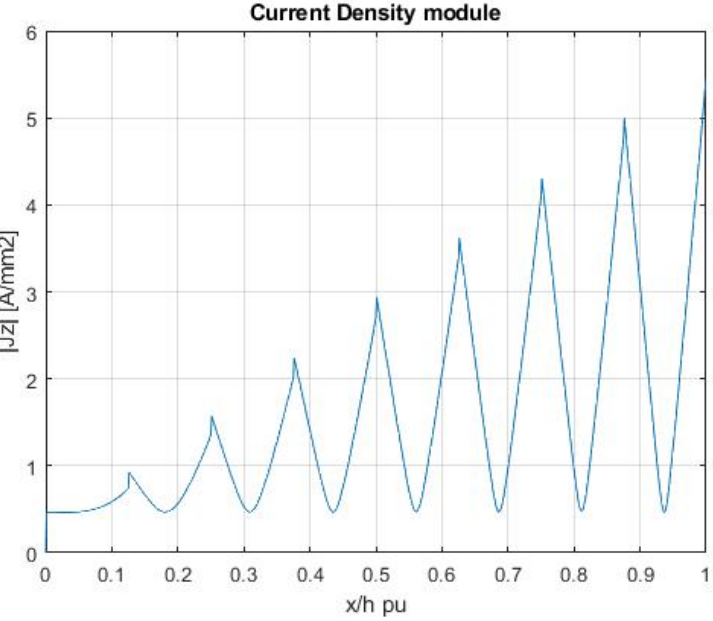
Figure 5. Current Density module for multiple